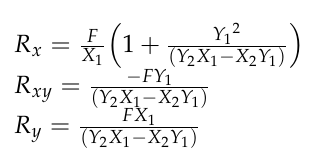
, k ( M 1 ) 1 and k ( M 1 ) 1 values as a function of the width x y xy